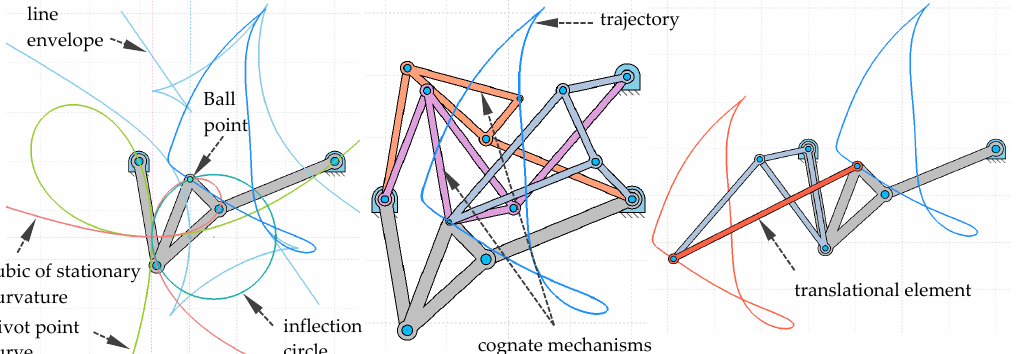
Figure 19. Line envelope, cubic of stationary curvature, pivot point curve, and Ball point. Cognates and derived translational